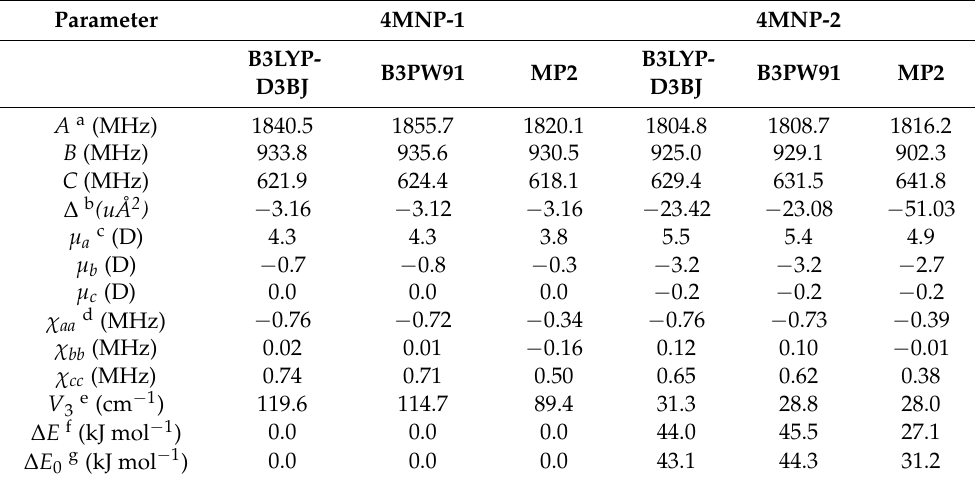
Table 1. Theoretical spectroscopic parameters of the two conformers of 4MNP calculated using the B3LYP-D3BJ, B3PW91, and MP2 methods with the 6-311++G(d,p) basis